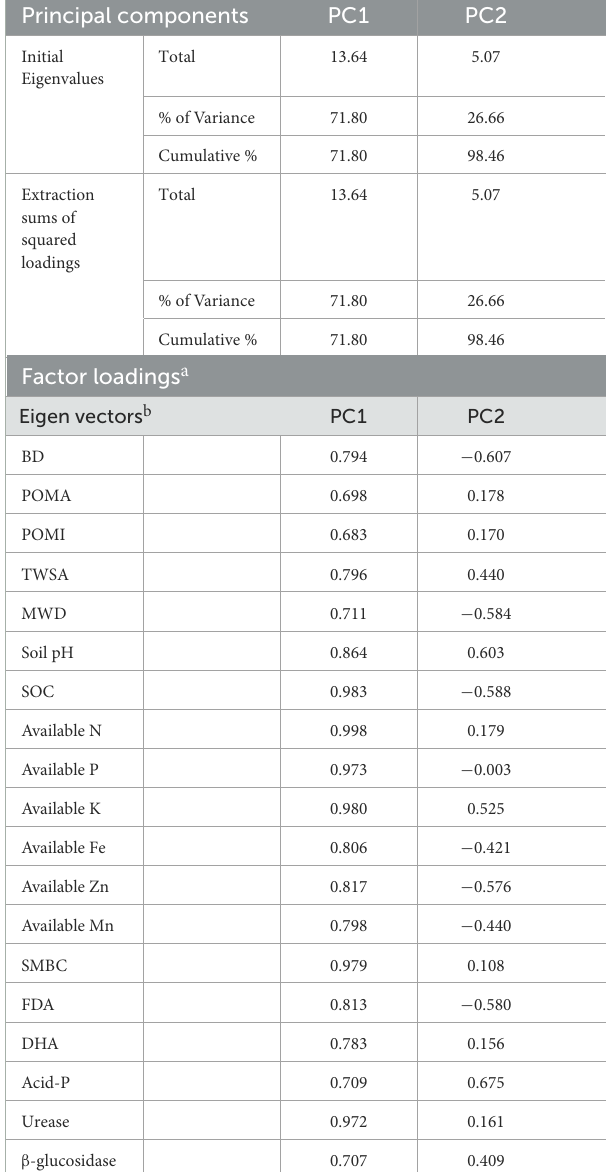
TABLE 3 Principal component analysis of physical, chemical, and biological properties of soil (after completion of two years). Principal